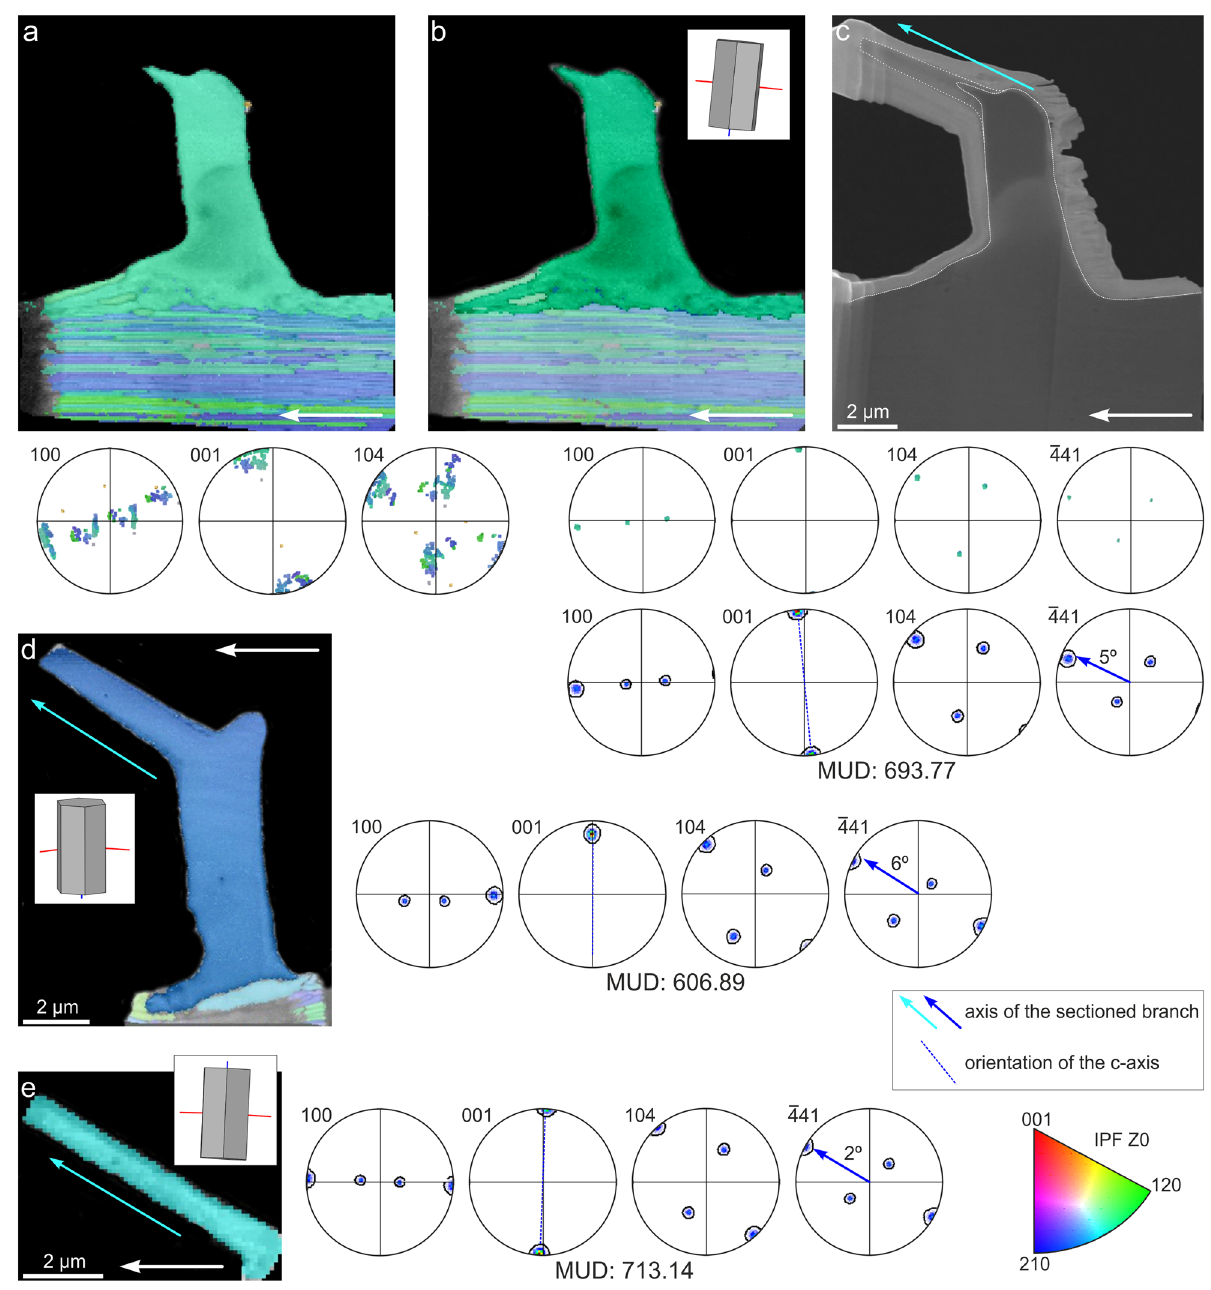
Figure 6. Crystallography of the second-order aerials and underlying prisms of Catillopecten natalyae analyzed by EBSD. ( a ) Orientation map and corresponding pole figures of an aerial and underlying foliated material. ( b ) Subset of the map in ( a ), where the orientation of the aerial has been selected. The corresponding cell lattice is shown. Note continuity with the topmost laminae of the foliated layer. The lower pole figures correspond to the subset. The top pole figures contain the raw data and the bottom ones are density plots. ( c ) STEM image of the FIB-prepared lamella, where the complete extension of the branch (axis indicated with arrow) can be seen. ( d ) Orientation map of a complete stem and branch. The main axis of the branch, the corresponding cell lattice, and representative pole figures are indicated. ( e ) Orientation map of an incomplete branch. The main axis of the branch, the corresponding cell lattice, and representative pole figures are indicated. The long white arrows indicate the shell growth direction. The deviation angle between the branch axis and the position of the − 441 poles is indicated in ( b ), ( d ) and ( e ). Colour key diagram (bottom right of figure) valid for all